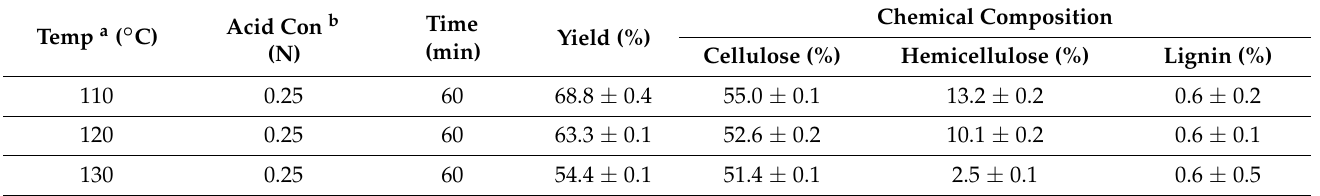
Table 2. Chemical composition of kenaf outer bast with different reaction temperatures of acid hy-